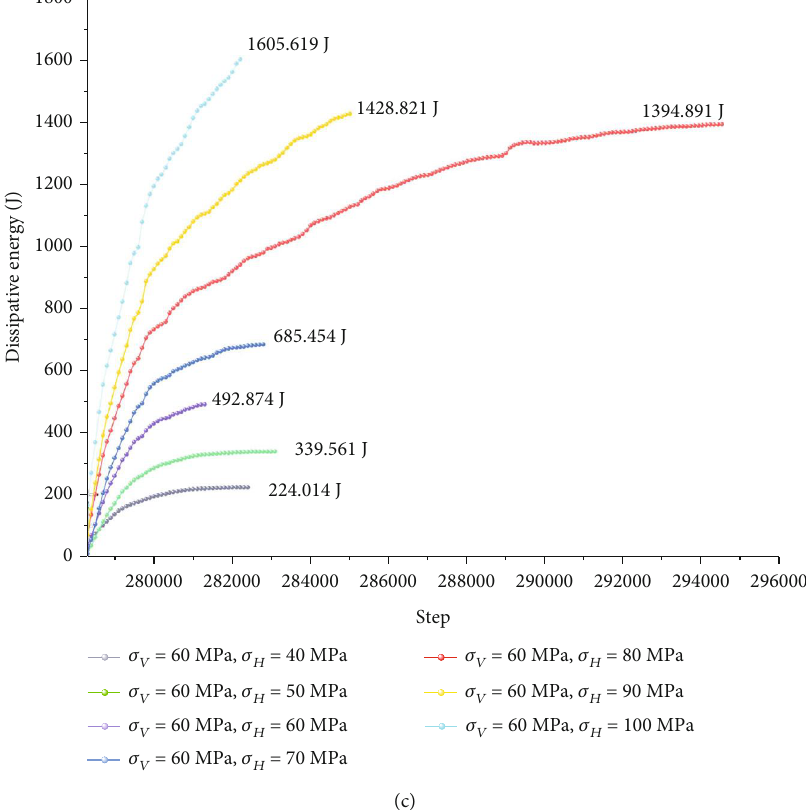
Figure 15: Variation diagrams of dissipated energy under di ff erent stress combination conditions. (a) Di ff erent hydrostatic pressure combinations. (b) Di ff erent axial stress combinations. (c) Di ff erent horizontal stress combinations.